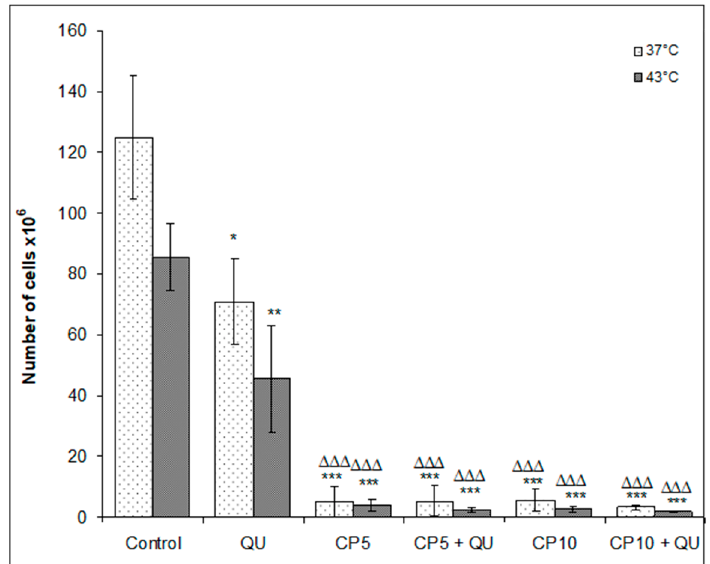
Figure 3. Total number of tumor cells in the intraperitoneal cavity of Swiss albino mice bearing Ehrlich ascites tumor after therapeutic treatment with cisplatin (CP) and quercetin (QU) under physiological and hyperthermic conditions. Mice were treated with CP (5 or 10 mg kg − 1 , i.p. ) 5 days after i.p. inoculation of EAT cells (2 × 10 6 /mouse) under physiological and hyperthermic conditions and with QU ( i.p. 50 mg kg − 1 ) at day 6 and 12 after i.p. inoculation of EAT cells. Results are reported as the mean ± SD ( n = 6). * Significantly different (nonparametric Kruskal–Wallis test, * p < 0.05; ** p < 0.01); *** p < 0.001) from control at 37 °C. Δ Significantly different ( ΔΔΔ p < 0.001, nonparametric Kruskal–Wallis test) from control group at 43 °C. Abbreviation: EAT, Ehrlich ascites tumor; QU, treatment with quercetin at a dose of 50 mg kg − 1 ; CP5 or CP10, treatment with cisplatin at doses of 5 or 10 mg kg − 1 .